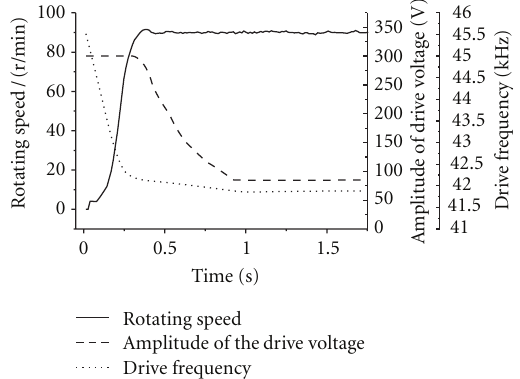
Figure 4: Tested data of speed